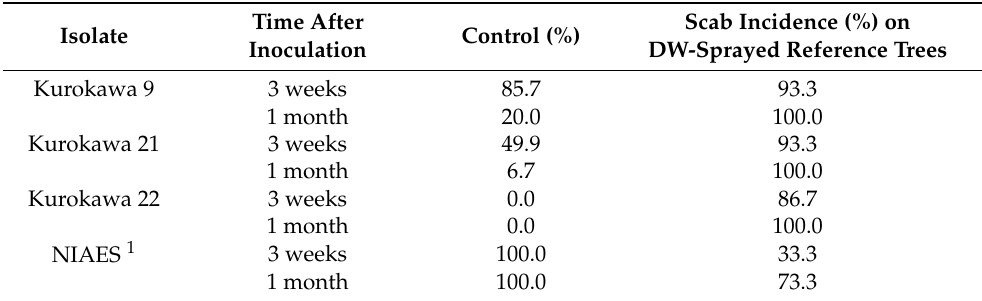
Table 3. Control efficacy of fenarimol (30 mg AI/L) on single-spore isolates of Venturia nashicola in